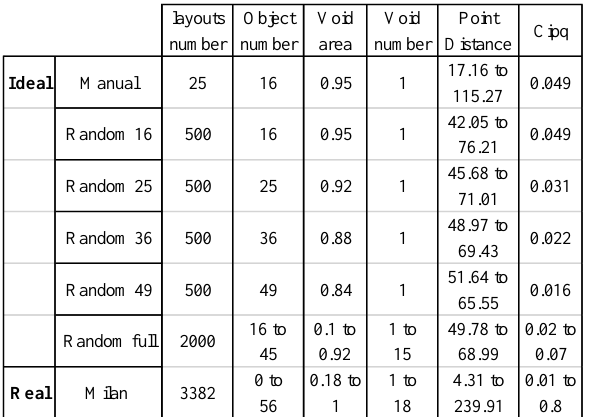
One key element of this process is the incremental buffer distance and its relationship with the sample area cell size. In fact, modifying it, the number of iterations required to reach limit values changes, and so does the number of clusters at each iteration. Given the transferability of this approach to